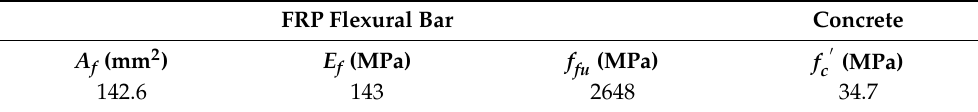
Table 6. Comparisons of predictions of shear design provisions and proposed data-driven Figure 9. Validation test setup and beam dimensions. Table 5. Material properties of the validation specimen.